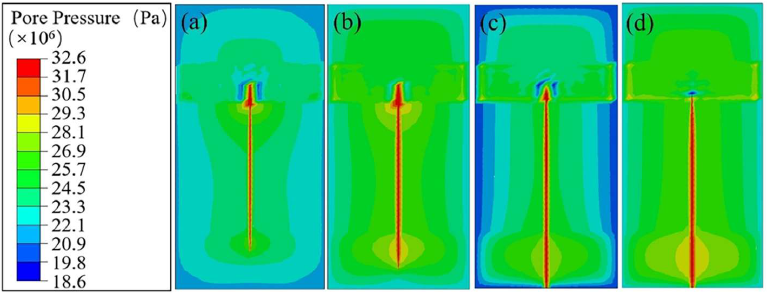
Figure 13. Pore pressure distribution cloud after fracturing under different leak-off coefficient con- ditions: ( a ) 1 × 10 − 7 , ( b ) 1 × 10 − 10 , ( c ) 1 × 10 − 13 , ( d ) 1 × 10 − 16 .